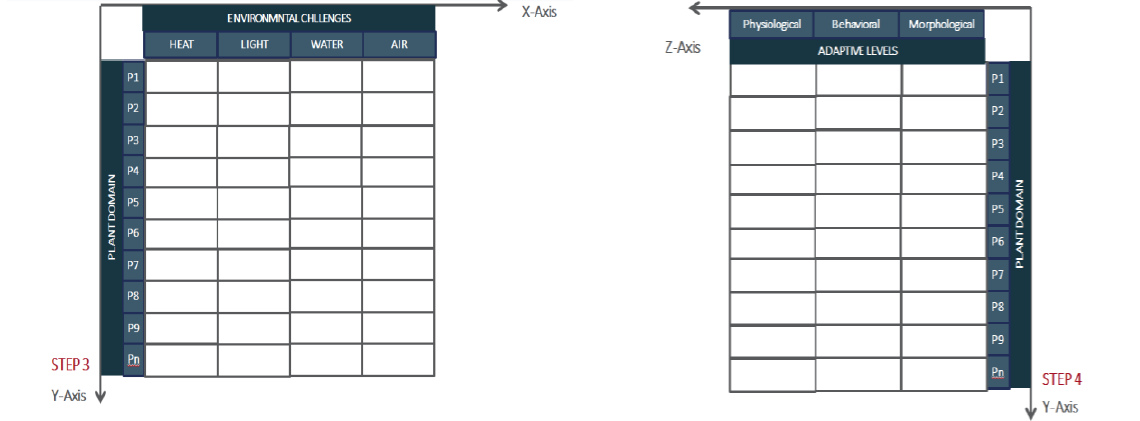
Figure 10 : On left: Matrix B: Describes the relation between the desired environmental regulation and the Plant’s adaptive strategies. On right: Matrix C: Shows the relation between the plant domain and the adaptive level (The researcher,